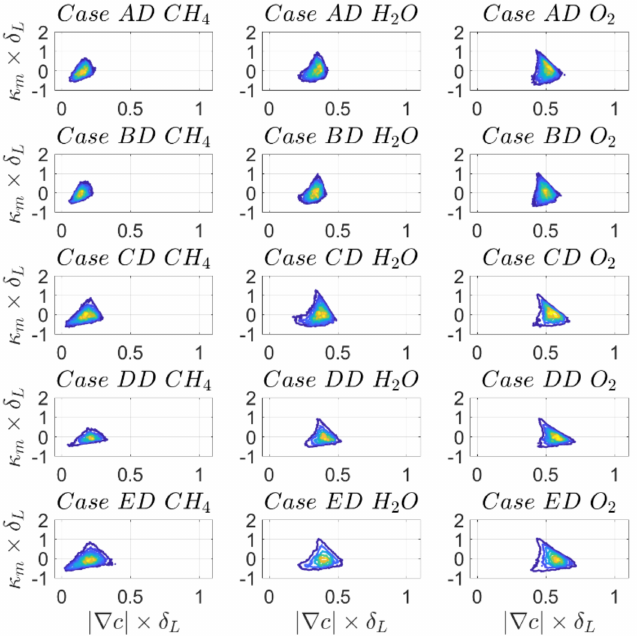
Figure A2. Joint PDF of SDF |∇ c | based on (1st to 3rd column) CH 4 , H 2 O,O 2 and normalised mean curvature κ m × δ L . All results are shown for c = 0.8 isosurface based on O 2 mass fraction, for top to bottom cases